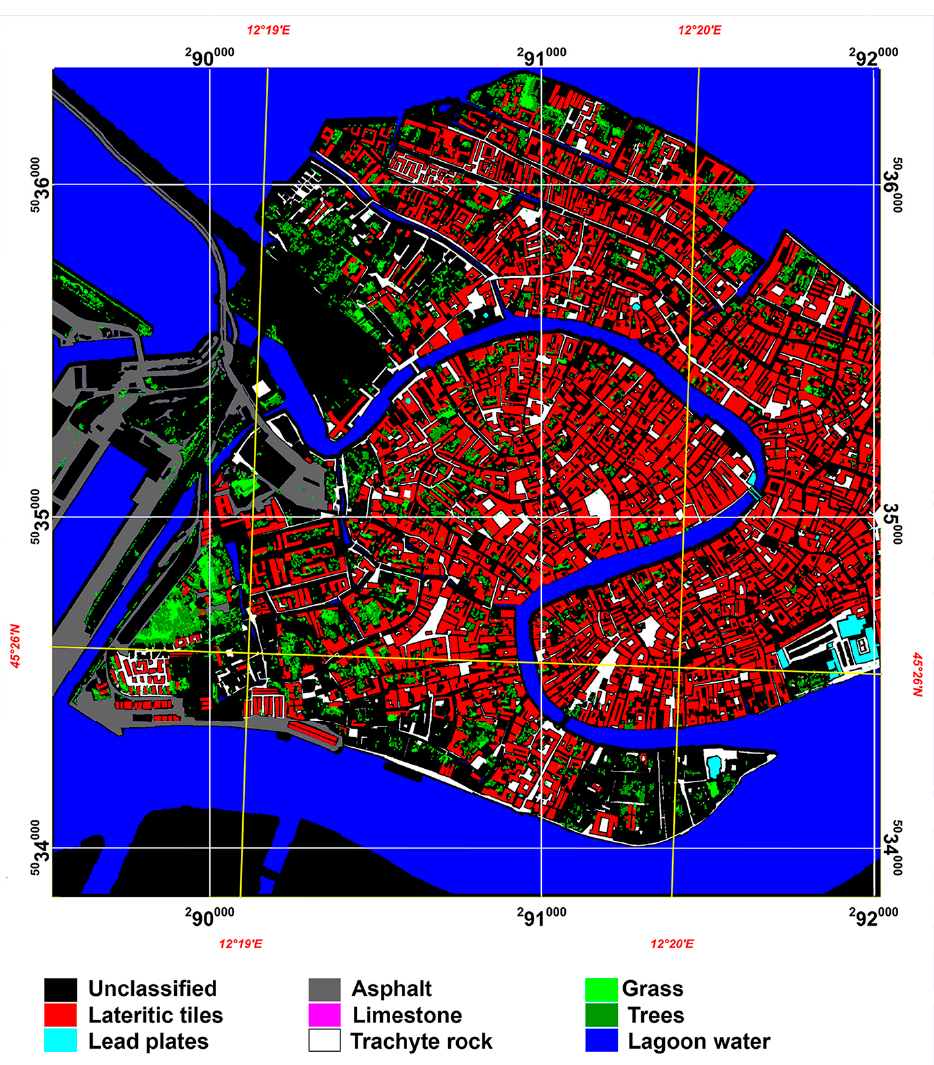
Figure 3. Reference map.